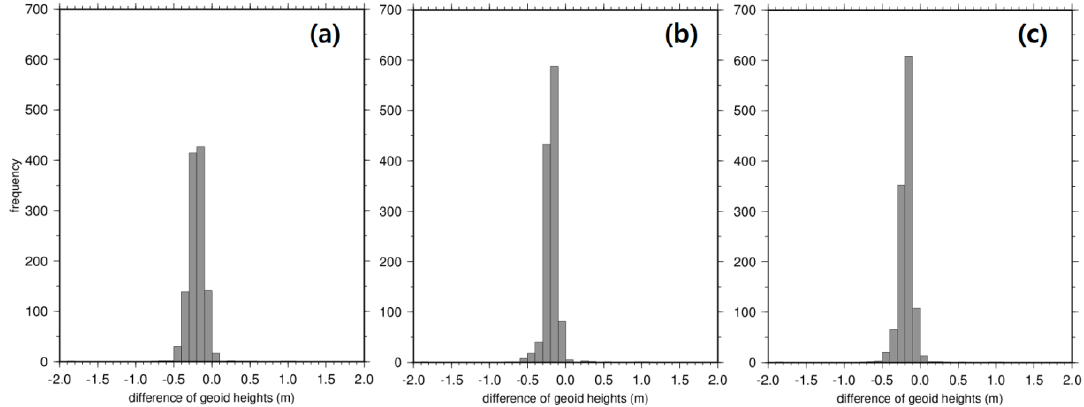
(cid:17) (cid:16) N GNSS / leveling derived from